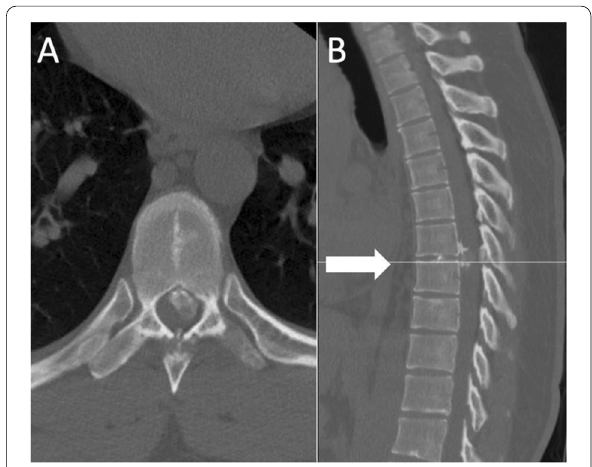
Fig. 2 Preoperative CT images in ( A ) axial and ( B ) sagittal views of the herniation at the indicated level